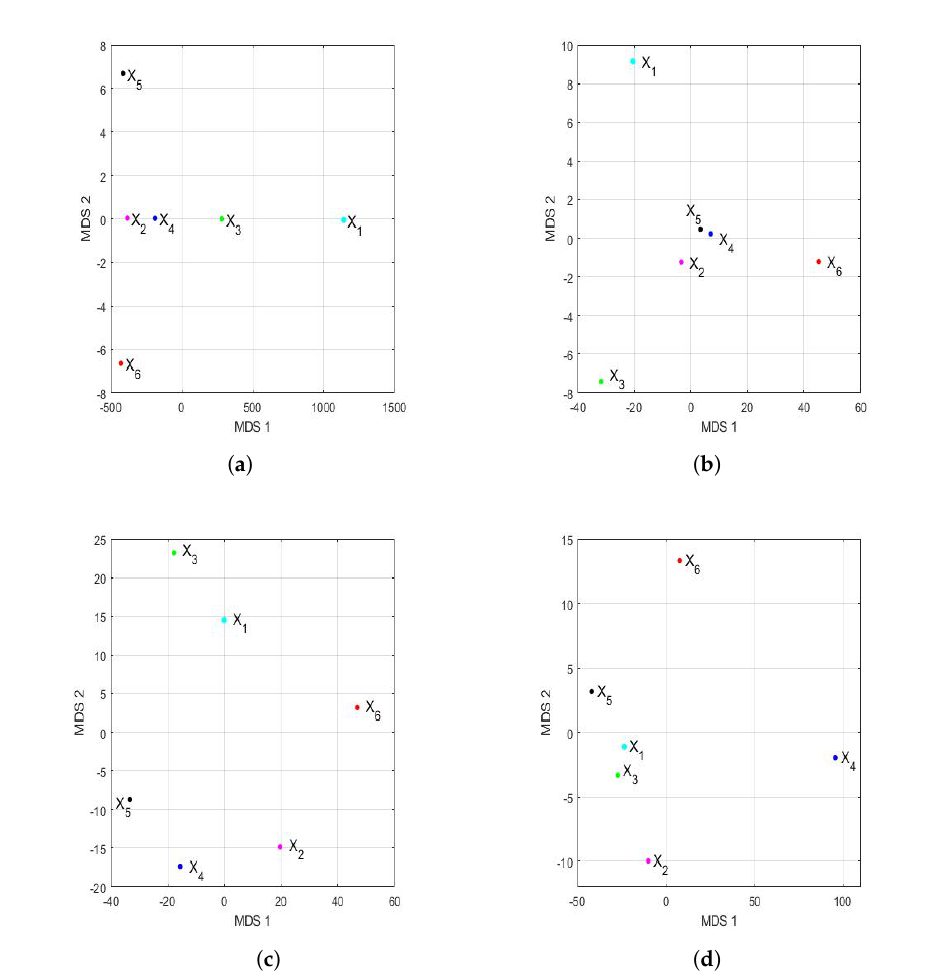
Figure 21. First two principal coordinates of the feature vectors by trimesters of each of the years of the 2015–2020 six-year term: X 1 (2015), . . ., X 6 (2020). ( a ) Feature vectors: first 2 principal coordinates of the first trimester. ( b ) Feature vectors: first 2 principal coordinates of the second trimester. ( c ) Feature vectors: first 2 principal coordinates of the third trimester. ( d ) Feature vectors: first 2 principal coordinates of the fourth trimester.